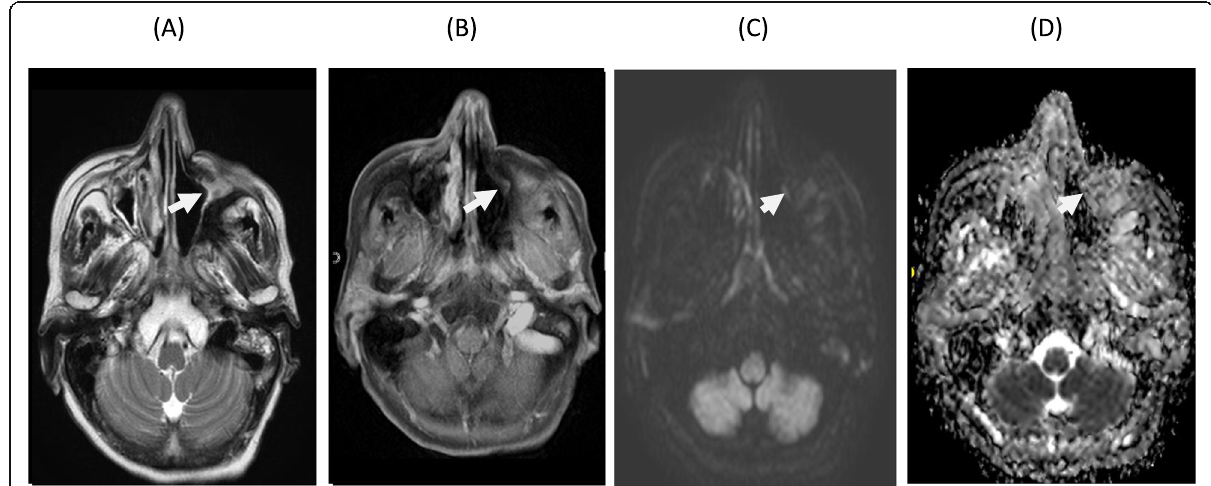
Fig. 6 Pathologically proven recurrent adenoid cystic carcinoma of the left maxilla following surgical resection and adjuvant chemoradiation. In this case, biopsy and histopathological examination revealed adenoid cystic carcinoma. However, the lesion was falsely diagnosed by diffusion- weighted imaging (DWI), i.e. wrongly interpreted as “ post-treatment benign changes ” . a Axial T2-weighted image (T2WI) showing a rather oblong sheet of high signal intensity at the operative bed (left maxilla). b Axial fat-saturated T1-weighted image (T1WI) post-contrast sequence showing faint, rather homogenous, enhancement of the lesion. c Diffusion-weighted imaging (b1000) revealing the intermediate-to-low signal intensity